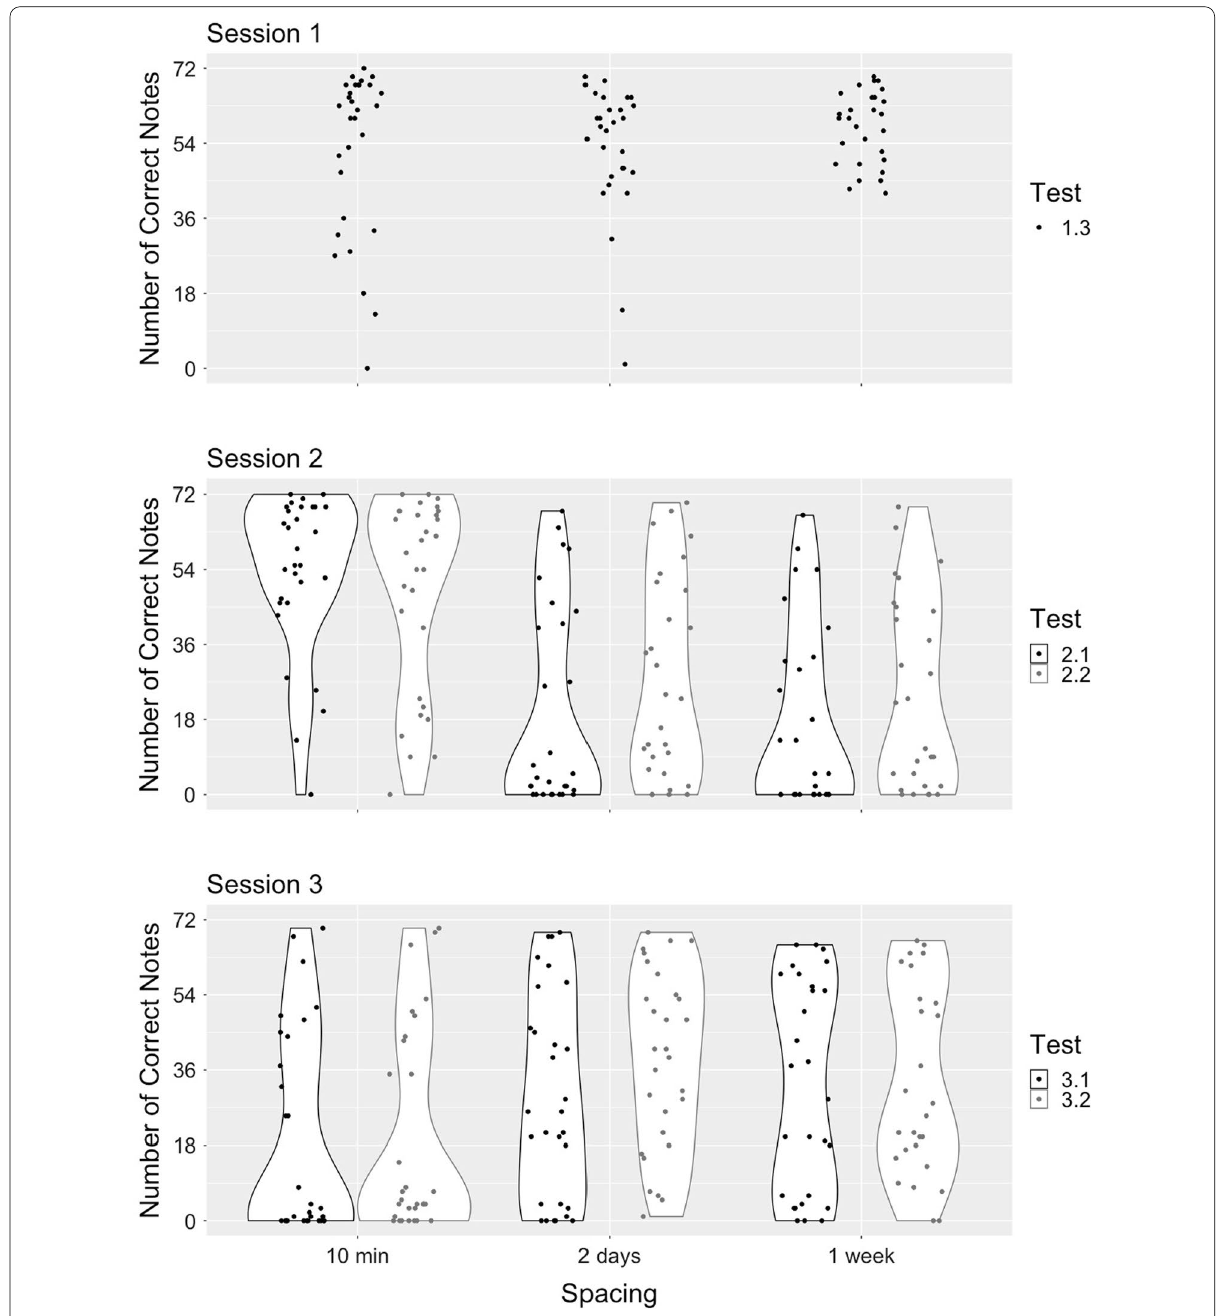
Fig. 2 Number of correct notes (test 1: cued by notes; test 2: cued by notes and